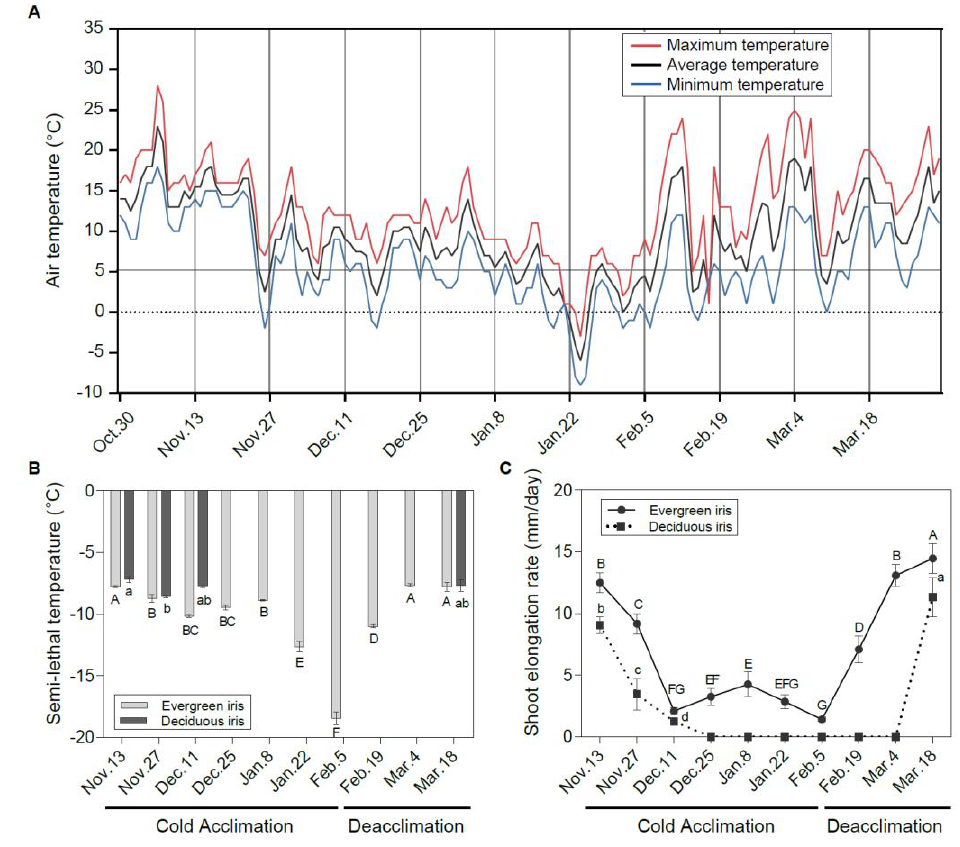
Figure 1. Freezing tolerance and vegetative growth status of leaves in evergreen and deciduous irises under natural cold acclimation and deacclimation. ( A ) Changes in air temperature from 30 October to 21 March 2021 in the field. The maximum temperature, average temperature and minimum temperature are indicated by red, black and blue lines, respectively. ( B ) Changes in semi-lethal temperature (LT 50 ) for functional leaves in evergreen and deciduous irises. ( C ) Alterations in the shoot elongation rate in evergreen and deciduous irises. Cold acclimation process, sampling from 13 November to 5 February 2021; deacclimation process, sampling from 19 February to 18 March 2021. The data are the means of three biological replicates, with different letters indicating significant differences between treatments according to Duncan’s multiple range test at p < 0.05. No functional leaves could be sampled from 25 December to 4 March 2021 in deciduous irises. Capital and lowercase letters represent significant differences for relevant parameters within evergreen and deciduous irises ( p < 0.05),